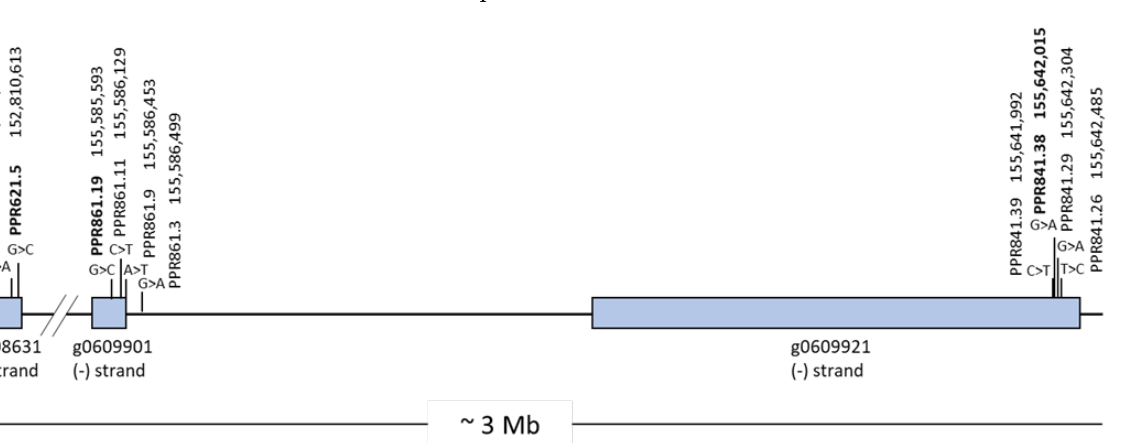
Figure 1. Locations of SNPs significantly associated with the fertility restorer locus Rf1 in the new sunflower genome assembly HanXRQr2. SNPs successfully used for KASP marker design are shown in bold.